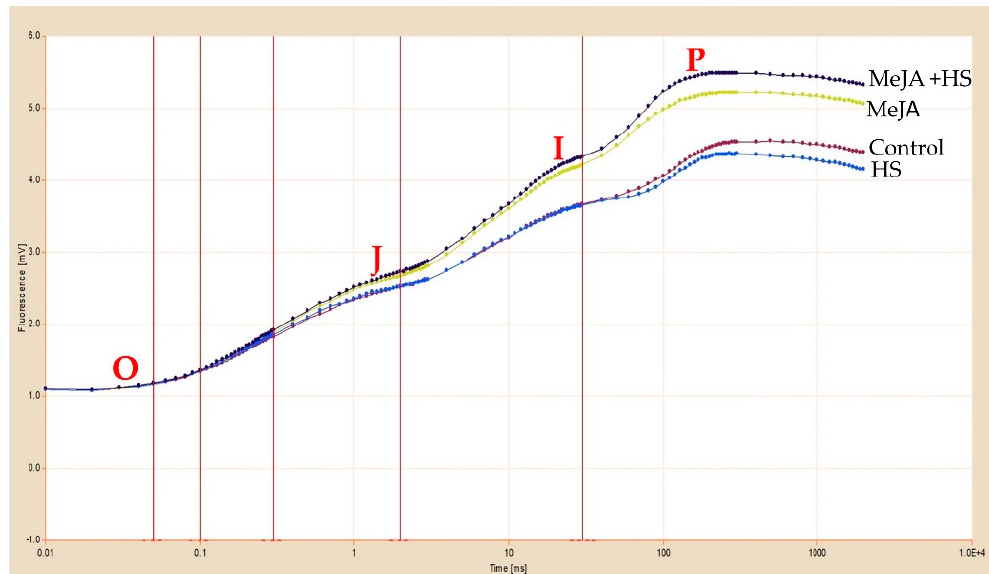
Figure 2. Chlorophyll fluorescence of OJIP curve in wheat leaves at 30 DAS. Plants were treated with MeJA (10 µM) at 42 °C (heat stress) or 25 °C (no stress). Data are presented as mean ± SE ( n = 4). DAS, days after sowing; HS, heat stress; MeJA, methyl jasmonate.